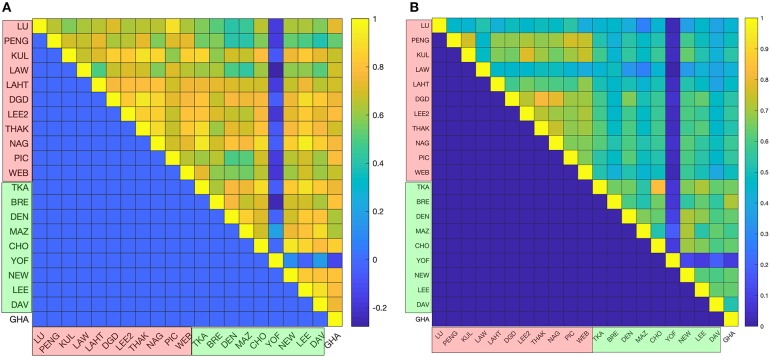
Statistical analyses of proteomics datasets. (A) Pairwise correlations between the ontological profiles obtained for the individual datasets. Correlations were measured using the Pearson correlation coefficient, whose values are color-coded (from the highest correlation in yellow to the lowest correlation in blue). (B) The ontology profile overlap between datasets is quantified using the Jaccard index and the color-code is the same as in the previous panel. In both panels mass spectrometry based datasets are indicated in red on the axes labeled as LU (Lu et al., 2007), PENG (Peng et al., 2012), KUL (Kulak et al., 2014), LAW (Lawless et al., 2016), LAHT (Lahtvee et al., 2017), DGD (De Godoy et al., 2008), PIC (Picotti et al., 2013), LEE2 (Lee et al., 2011), THAK (Thakur et al., 2011), NAG (Nagaraj et al., 2012), and WEB (Webb et al., 2013); GFP datasets are shown in green on the axes and are labeled as TKA (Tkach et al., 2012), BRE (Breker et al., 2013), DEN (Denervaud et al., 2013), MAZ (Mazumder et al., 2013), CHO (Chong et al., 2015), YOF (Yofe et al., 2016), NEW (Newman et al., 2006), LEE (Lee et al., 2007), and DAV (Davidson et al., 2011); and the TAP-immunoblot dataset is shown in white on the axes and is labeled as GHA (Ghaemmaghami et al., 2003). The top 200 proteins are shown to have a similar gene ontology profile across all of the datasets.